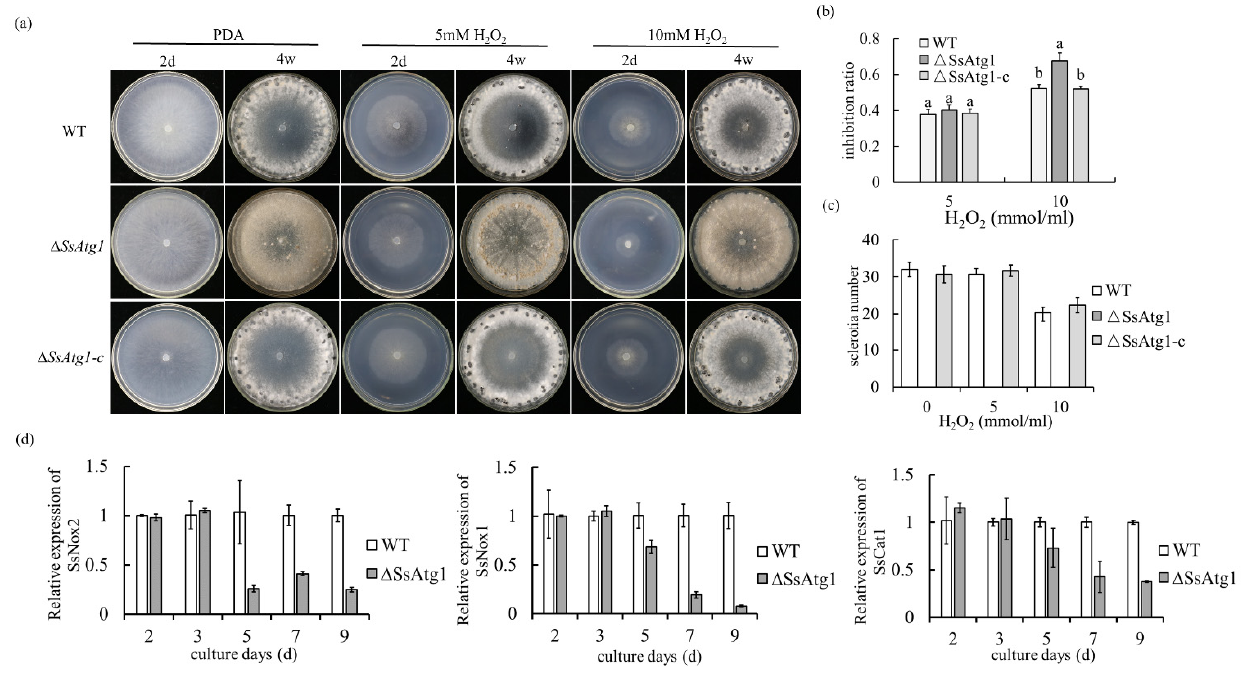
Figure 8. ∆ SsAtg1 hypersensitivity to ROS. ( a ) Mycelia growth and morphology of the ∆ SsAtg1 under different concentrations of H 2 O 2 . ( b ) Inhibition rate analysis. Inhibition rate = (colony diameter of strain without H 2 O 2 − colony diameter of strain with H 2 O 2 )/ colony diameter of strain without H 2 O 2 × 100%. Error bars represent the standard deviations and the letters indicated significant differences ( p < 0.05). ( c ) Statistics of sclerotia number. Significant difference in data by SPSS software ( p < 0.05), error bars represent standard deviation. ( d ) Expression of reactive oxygen metabolism genes.